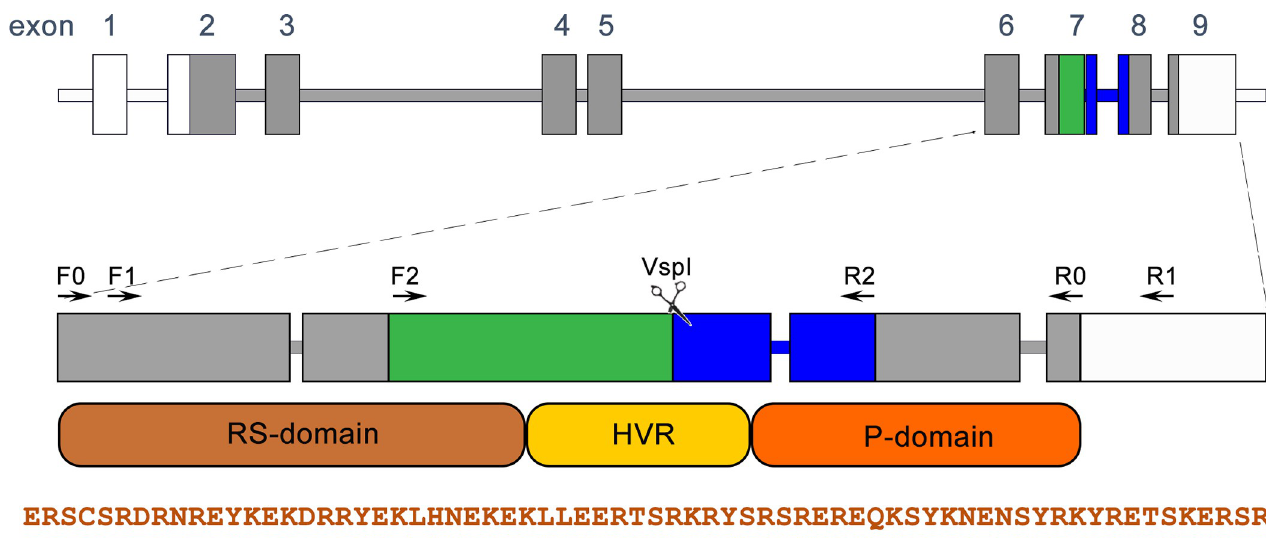
Fig 1. Organisation of the Apis mellifera csd gene locus. Rectangles represent exons and white exons or their fragments represent non-coding parts of the gene. Arrows represent the position of primers used in this study. The green and blue fragments of exons 7 and 8 represent the localization of the amplicon and its restriction fragments analysed by the T-RFLP method used in this work. The amino acid sequence of an example of a potential-specifying domain of the csd protein (csd-PSD) is given together with the localization of its arginine/serine-rich domain (RS-domain, brown), hypervariable region (HVR, yellow) and proline-rich domain (P-domain,